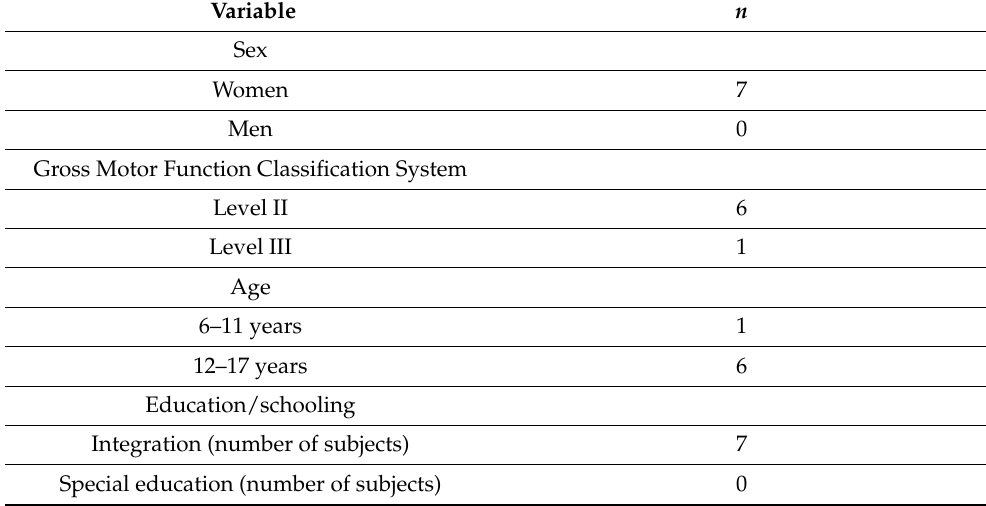
Table 1. Sample Baseline Description.